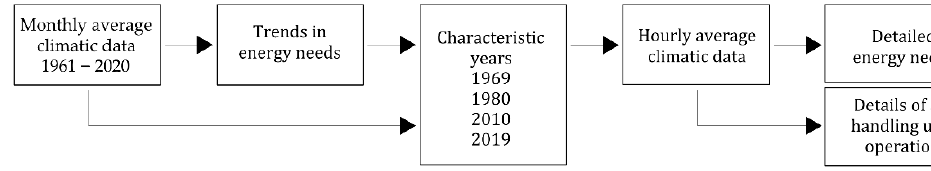
Figure 5. Procedure scheme.